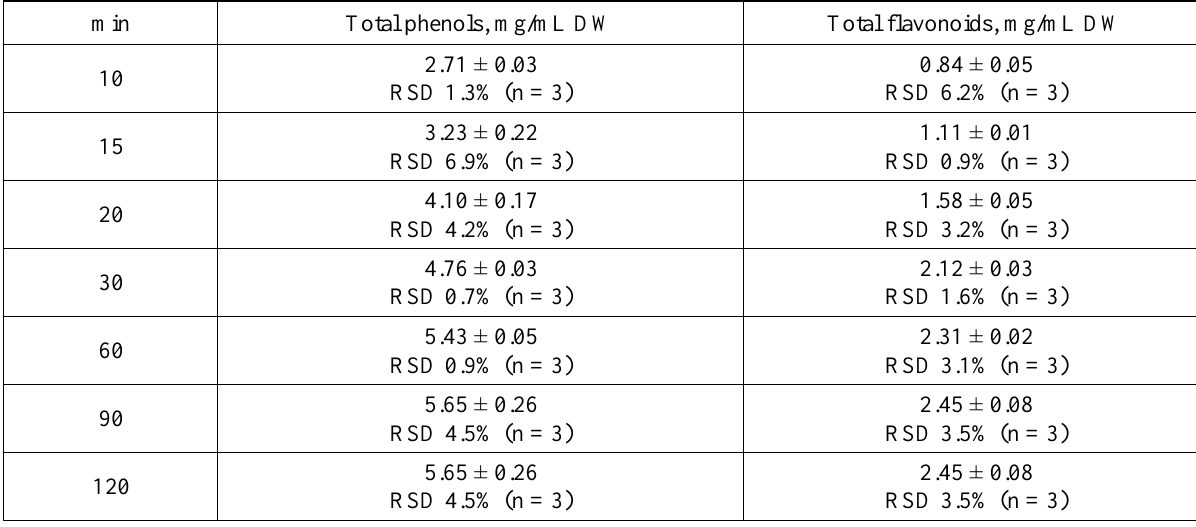
Table 1. Kinetic varieties of 50% aqueous ethanol extract of Cichorium intybus L. leaves in total phenols and total flavonoids